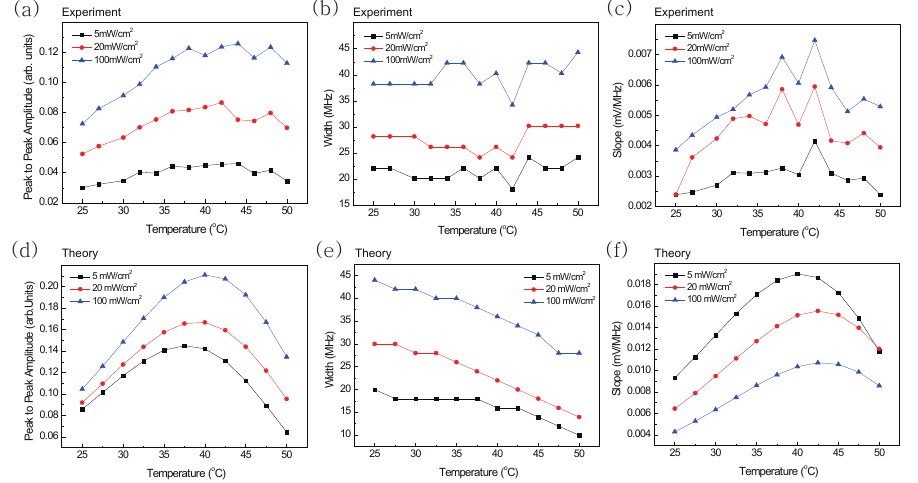
F e = 3 transition line on the change of Figure 4. Dependence of the PS signal of 87 Rb F g = 2 → vapor cell temperature (25 ◦ C to 50 ◦ C) under three different pump beam intensities (5 mW/cm 2 , 20 mW/cm 2 , and 100 mW/cm 2 ). The probe beam intensity I pr was 1.6 mW/cm 2 . Further, ( a – c ), and ( d – f ) are the experimental and theoretical results, respectively, of the amplitude, width, and slope of the PS